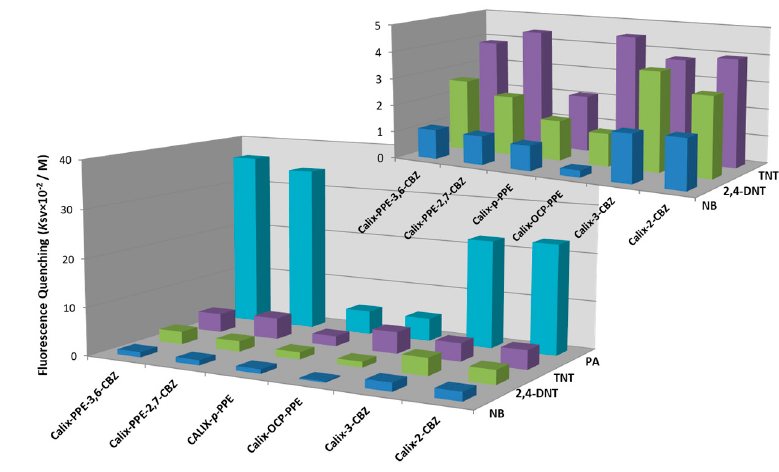
Figure 2. Fluorescence quenching (corrected K SV ) of Calix-PPE-CBZs ( λ exc = 360 nm), Calix- p -PPE and Calix-OCP-PPE ( λ exc = 380 nm), and Calix-CBZs ( λ exc = 360 nm) by NACs in CHCl 3 solution. Inset: expanded data for TNT, 2,4-DNT and NB analytes.